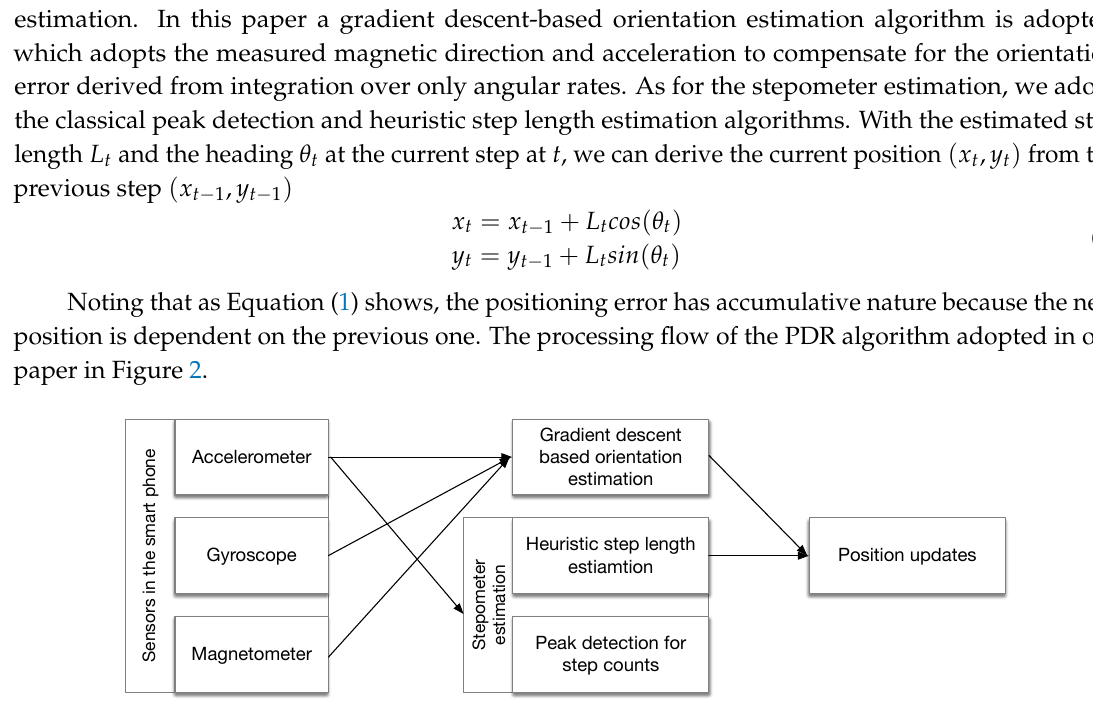
Figure 2. The processing flow for PDR in this